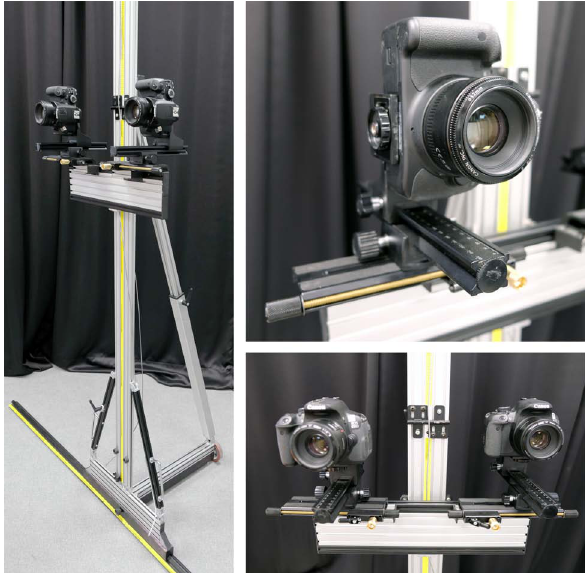
Figure 5: Views of the mechanical structure ; complete system on the traveling rail (left), close-up on the double micrometric plates (X and Z) with a camera vertically mounted (upper-right) and close-up on Y translation plate with two cameras in horizontal position